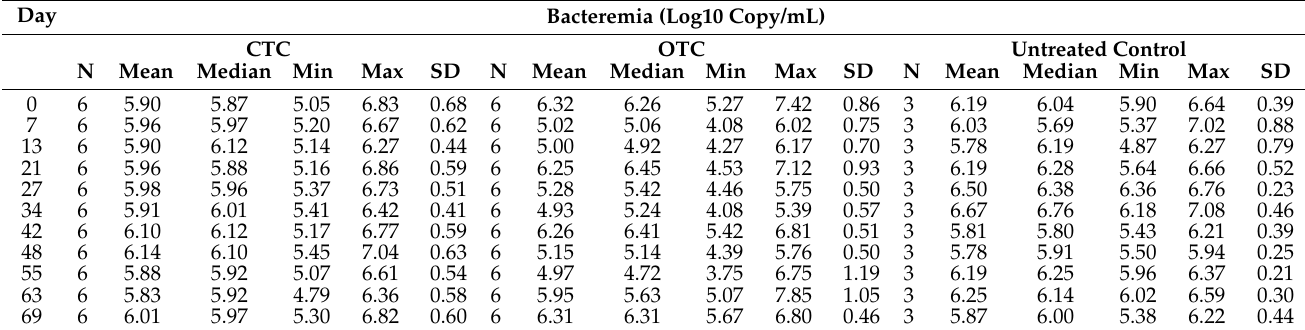
Table 1. Summary of steer Am bacteremia values by study day and treatment group.